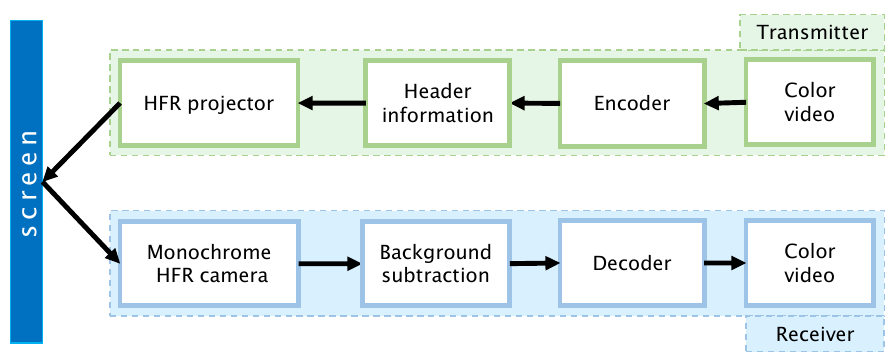
Figure 10. Visual-feedback-based projector–camera system block diagram.